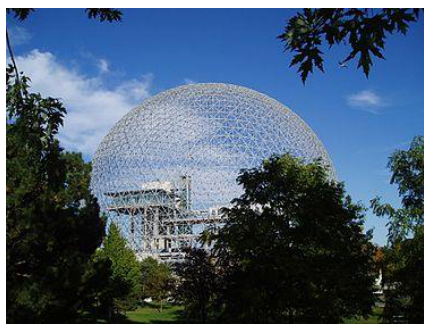
Fig. 21 The Montréal Biosphère (Fueller,1967)